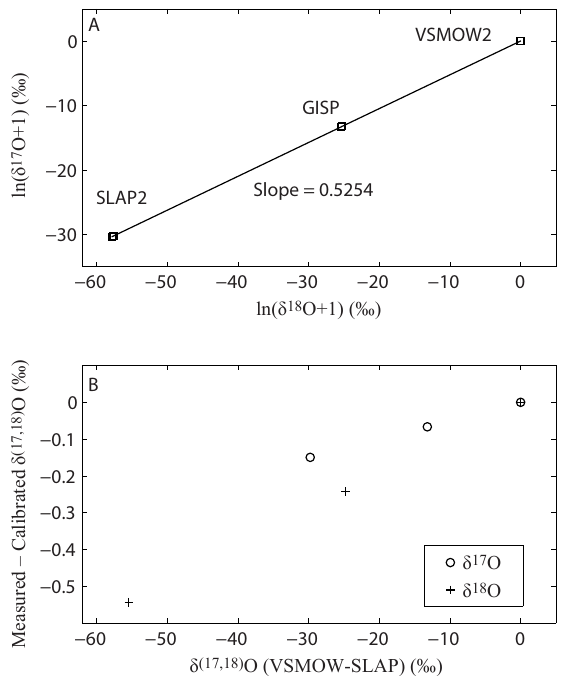
Figure 7. Characterization of scale compression on the L2140- i . (A) Measured (vs. VSMOW) ln (δ 17 O + 1 ) vs. ln (δ 18 O + 1 ) for VSMOW2, SLAP2 and GISP. (B) Difference between measured and calibrated δ 17 O and δ 18 O of VSMOW2, SLAP2 and GISP as a function of the calibrated